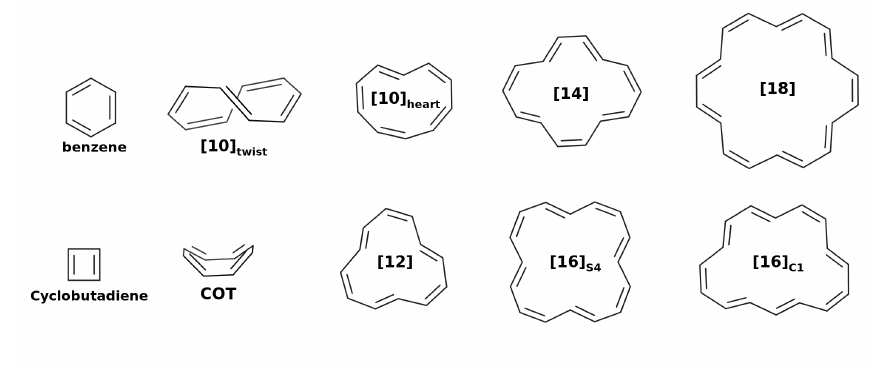
Figure 2. Geometrical structures of the studied